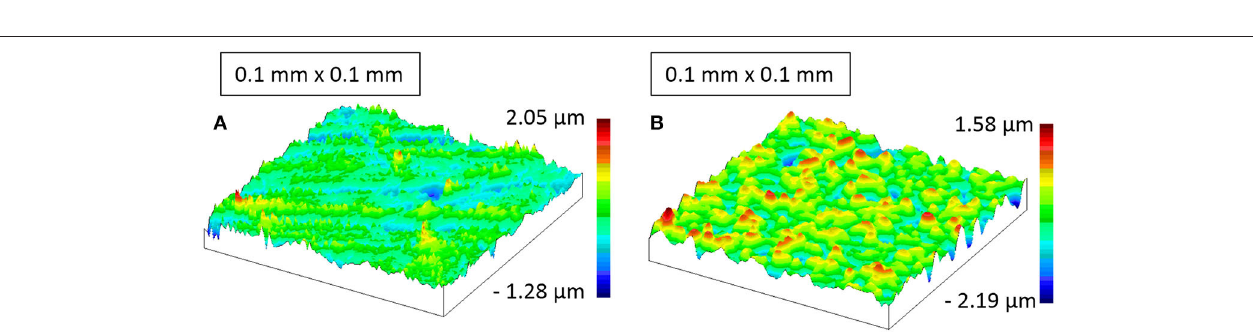
also articulated, and local elevations can be found here as